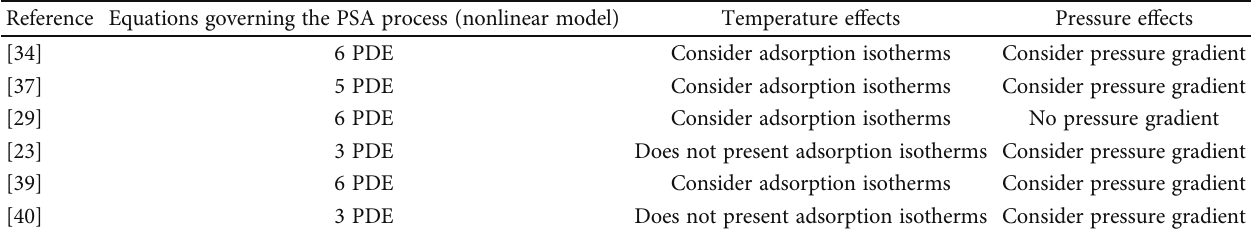
Table 4: Distributed parameter models of the PSA processes for bioethanol production.